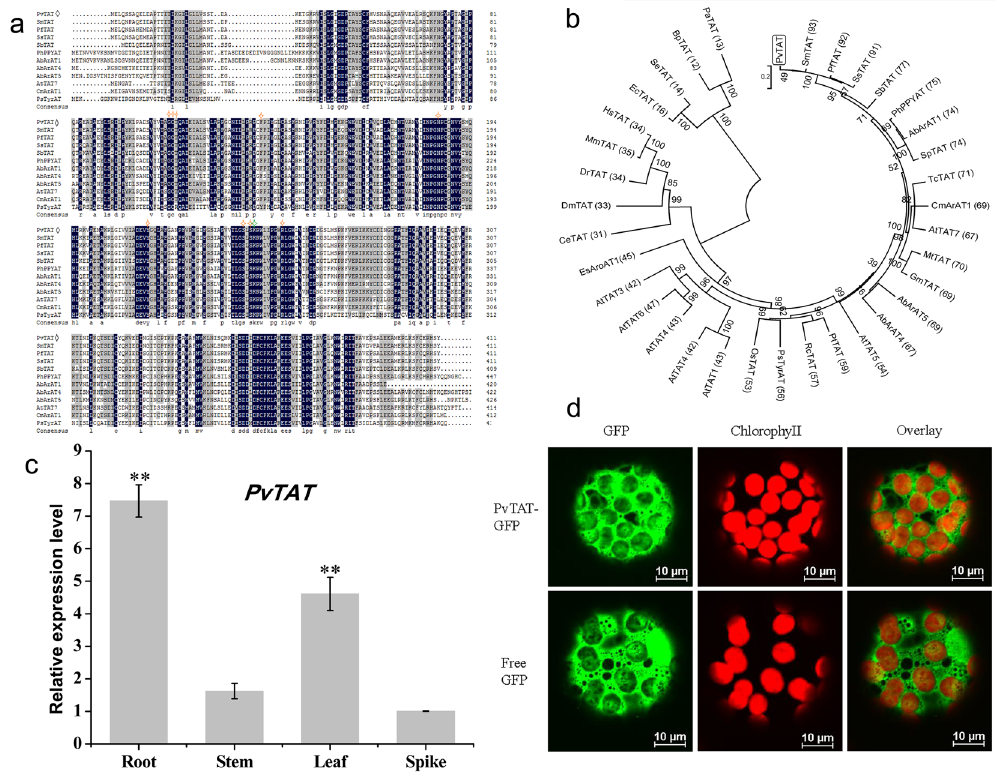
Figure 2. Multiple sequence alignment, phylogenetic tree, expression pattern, and subcellular localisation of P . vulgaris TAT. ( a ) Amino acid sequence alignment of tyrosine aminotransferase (PvTAT) from Prunella vulgaris and selected homologs. The amino acid alignment was generated using DNAMAN 7.0. Identical and similar amino acids are shaded in black and gray, respectively. The catalytic site of the lysine residue is marked with green asterisk. The pyridoxal-5 ′ -phosphate binding sites are marked with orange asterisks. PvTAT is marked with rhombus. Abbreviations are defined in the Table S1. ( b ) Phylogenetic relationship of and related proteins. An unrooted neighbour-joining tree was constructed using MEGA 5.05 software. Numbers refer to the percentage bootstrap test support for each node over 1,000 bootstrap iterations. Numbers in parentheses show the percentage amino acid identity of each protein compared with TAT from P . vulgaris . The identifiers of the proteins are provided in Supplemental Table S1. ( c ) Relative expression of PvTAT in various organs of P . vulgaris . Gene relative expression was determined by qRT-PCR and is shown relative to the expression level of the housekeeping gene β -actin. Relative expression was calculated using the 2 −ΔΔ t method.Transcripts of PvTAT in spikes were set to 1. Data are means ± SD of three replicates. * P < 0.05 and ** P < 0.01 as determined by Tukey HSD test. ( d ) Subcellular localisation of PvTAT. The PvTAT - GFP or free GFP construct was expressed in tobacco protoplasts and the fluorescence was observed under a confocal microscopy. PvTAT-GFP fusion protein localises in the cytoplasm in tobacco protoplasts. Free GFP served as the control. GFP fluorescence is in green and chloroplasts fluorescence is in